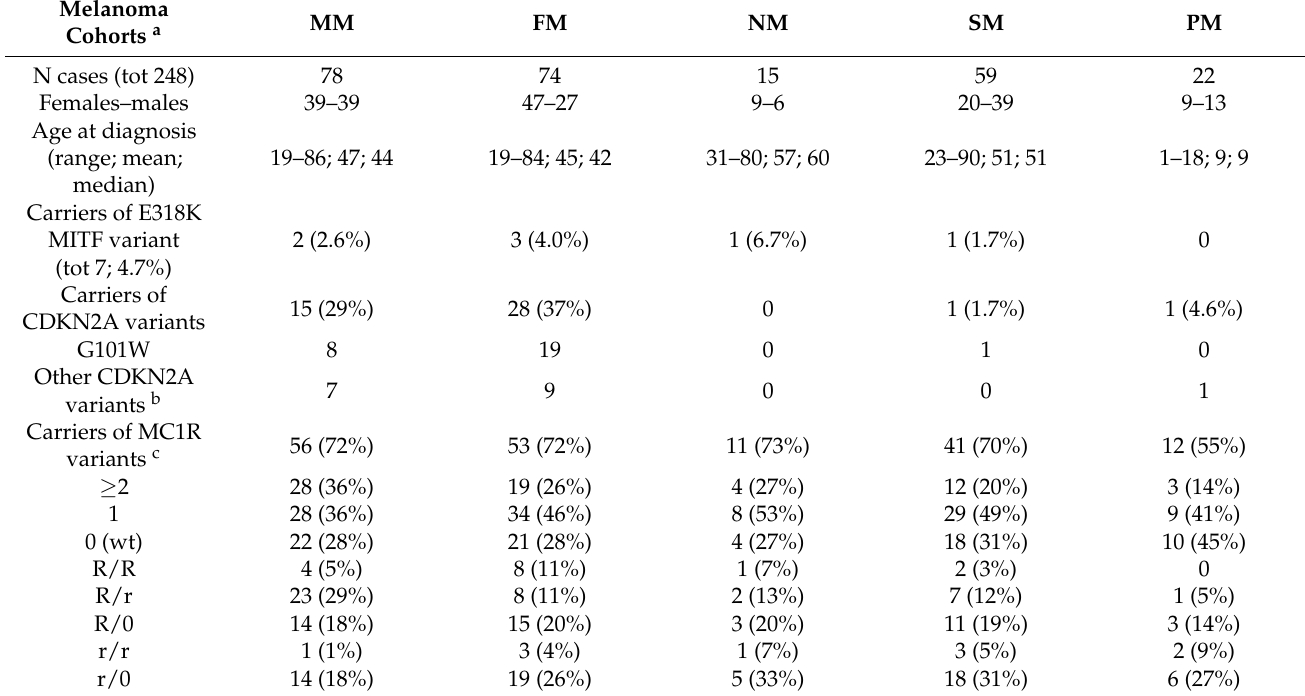
Table 1. All the studies were approved by the Institutional Review Board and the Indepen- dent Ethics Committee and written informed consent was obtained from participants. Table 1. Genetic characteristics of the studied cohorts of CM